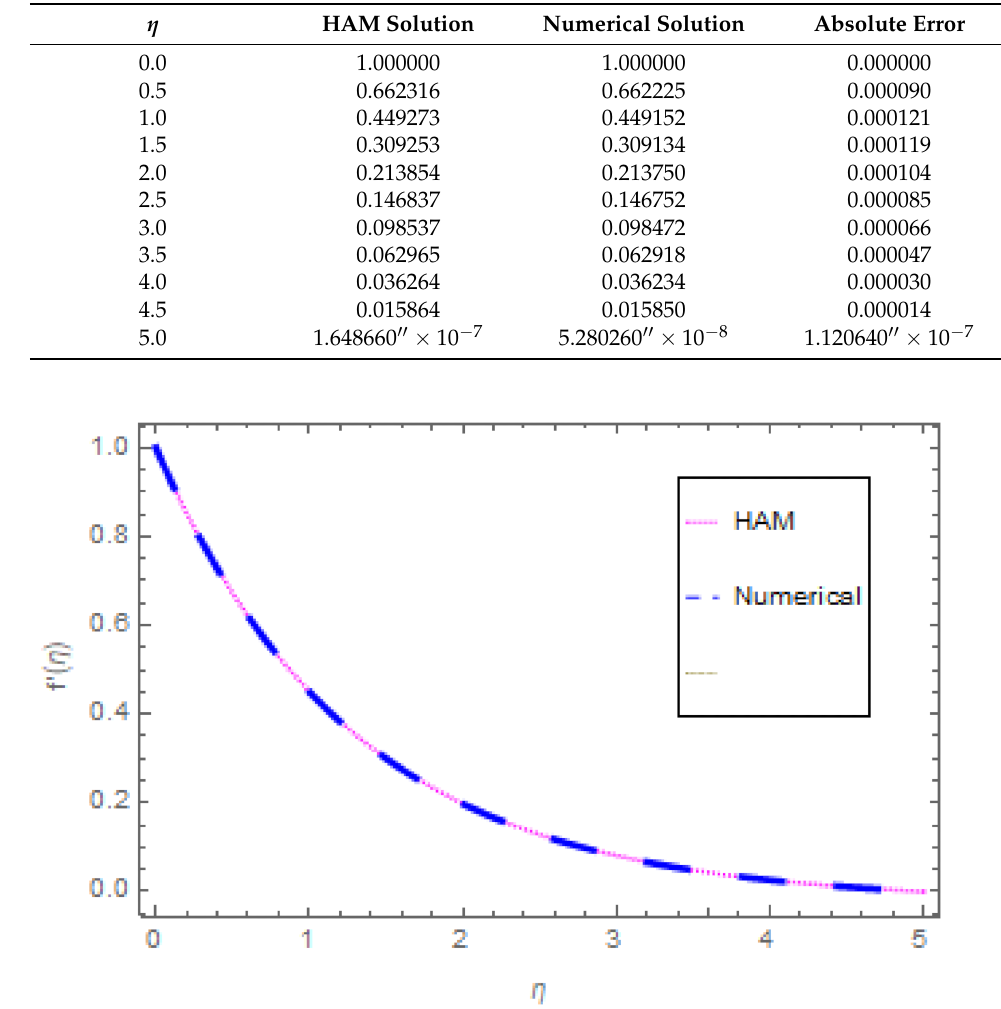
Figure 2. Comparison graph for velocity